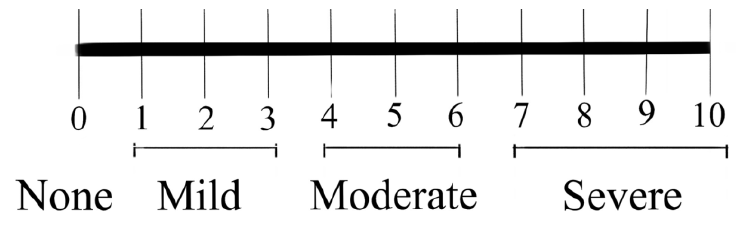
Figure 1. Numerical rating scale for pain assessment.